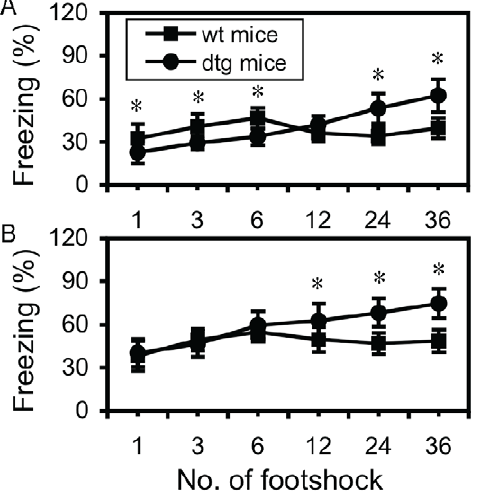
Figure 3. Quantitative interaction between CCKR-2 transgene and stress in fear response. (A) Freezing rate in contextual conditioning in the retention test in mice that were subjected to gradient trials of footshock in. * in 1, 3, 6, 24, and 36 trials of footshock represent p , 0.05, , 0.01, , 0.001, , 0.001, and , 0.001, respectively. (B) Freezing rate in cued conditioning in the same mice. * in 12, 24, and 36 trials of footshock represent p , 0.05, , 0.001, and , 0.001, respectively. All are Student’s t tests. Data are expressed as mean 6 SD.